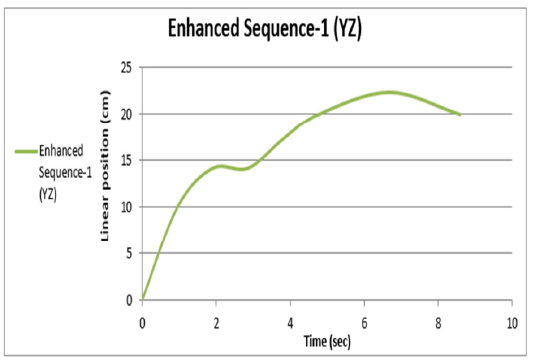
Fig. 16. Enhanced sequence (YZ) for the second obstacle.